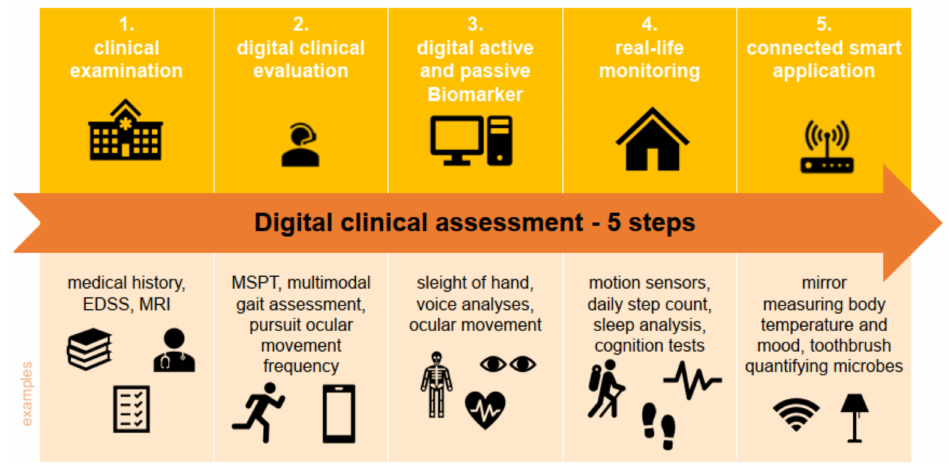
Figure 1. Developing a digital clinical assessment. (EDSS: Expanded Disability Status Scale; MRI: magnetic resonance imaging; and MSPT: Multiple Sclerosis Performance Test). © Multiple Sclerosis Center